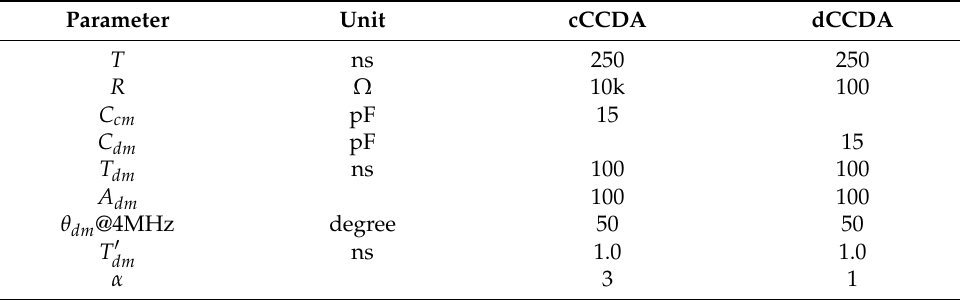
Table 4. Parameters for the cCCDA and dCCDA designs.